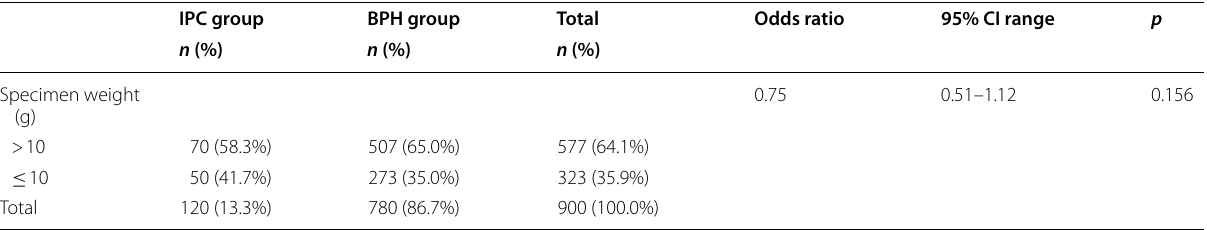
IPC ıncidental prostate cancer, BPH benign prostatic hyperplasia, CI confidence interval